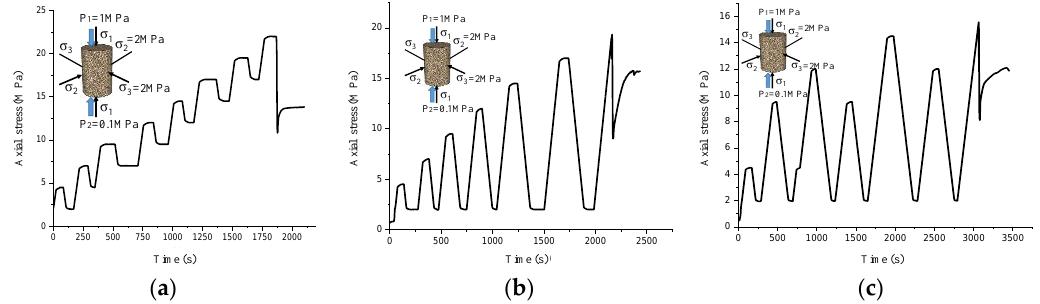
Figure 6. Three cyclic loading–unloading stress paths. ( a ) Stress path 1: stepped-loading and unloading. ( b ) Stress path 2: stepped-increasing-loading and unloading. ( c ) Stress path 3: crossed-cyclic-loading and unloading.